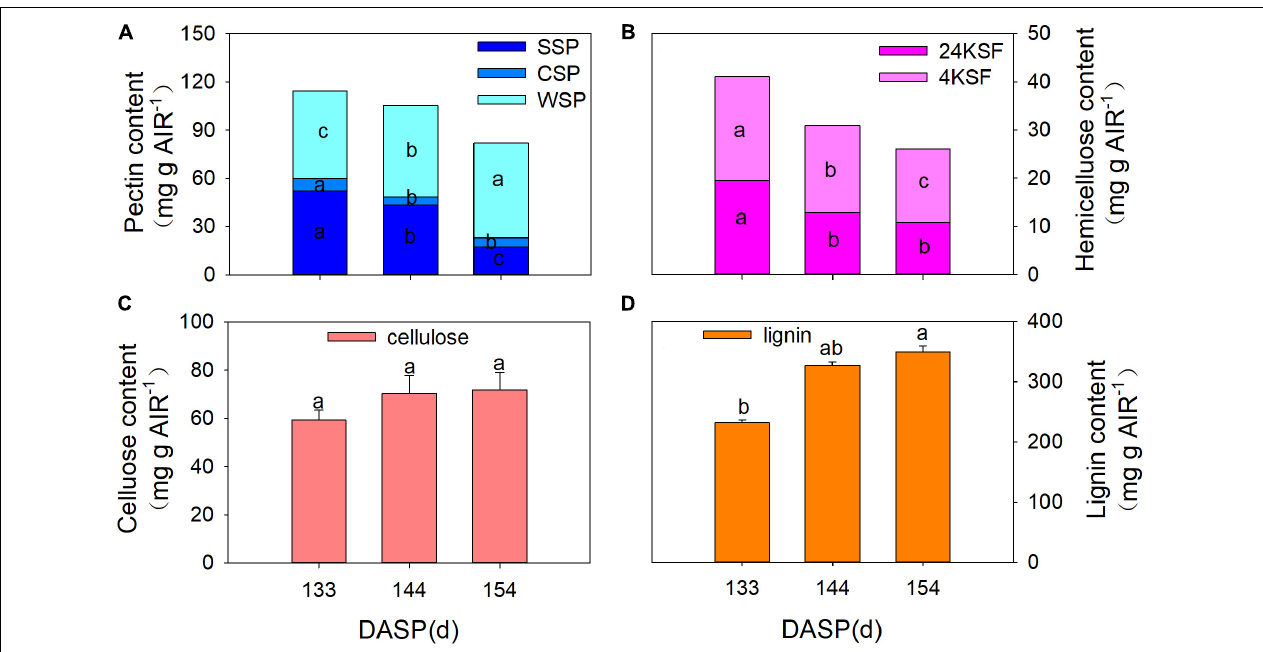
FIGURE 3 | Changes in aril cell wall components in Torreya grandis during seed development stages. (A) WSP, water solubilized pectin, CSP, CDTA solubilized; SSP, Na2CO3 solubilized. (B) 24KSF, 24% KOH-soluble hemicellulose fraction; 4KSF, 4% KOH-soluble hemicellulose fraction. (C) Cellulose and (D) lignin. Different lowercase letters indicate a significant difference at different growth stages by Duncan’s multiple range test ( P < 0.05). N = 3.